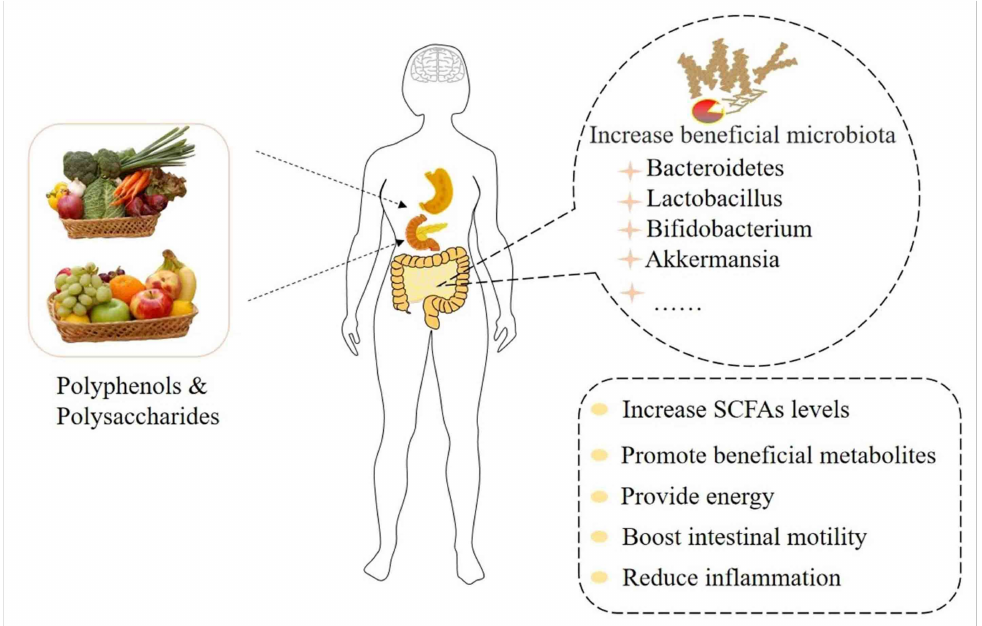
Figure 2. Prebiotics are converted by intestinal